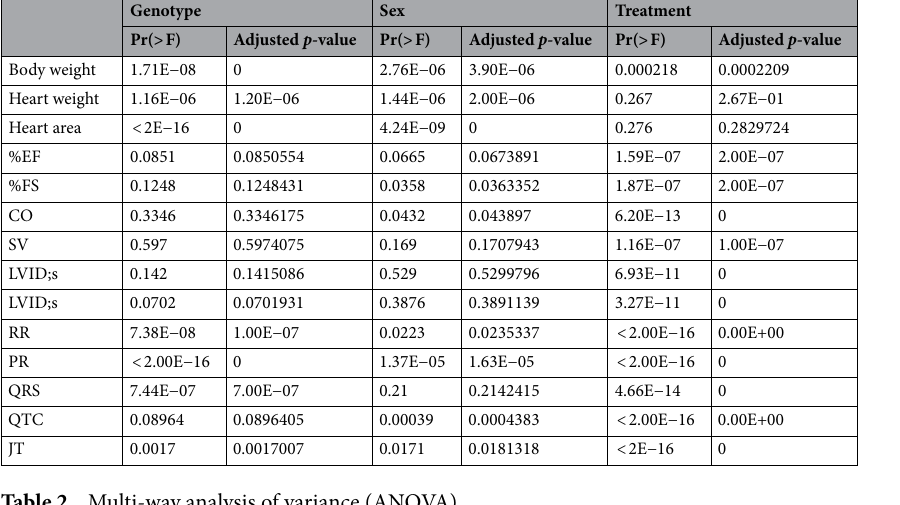
Table 2. Multi-way analysis of variance